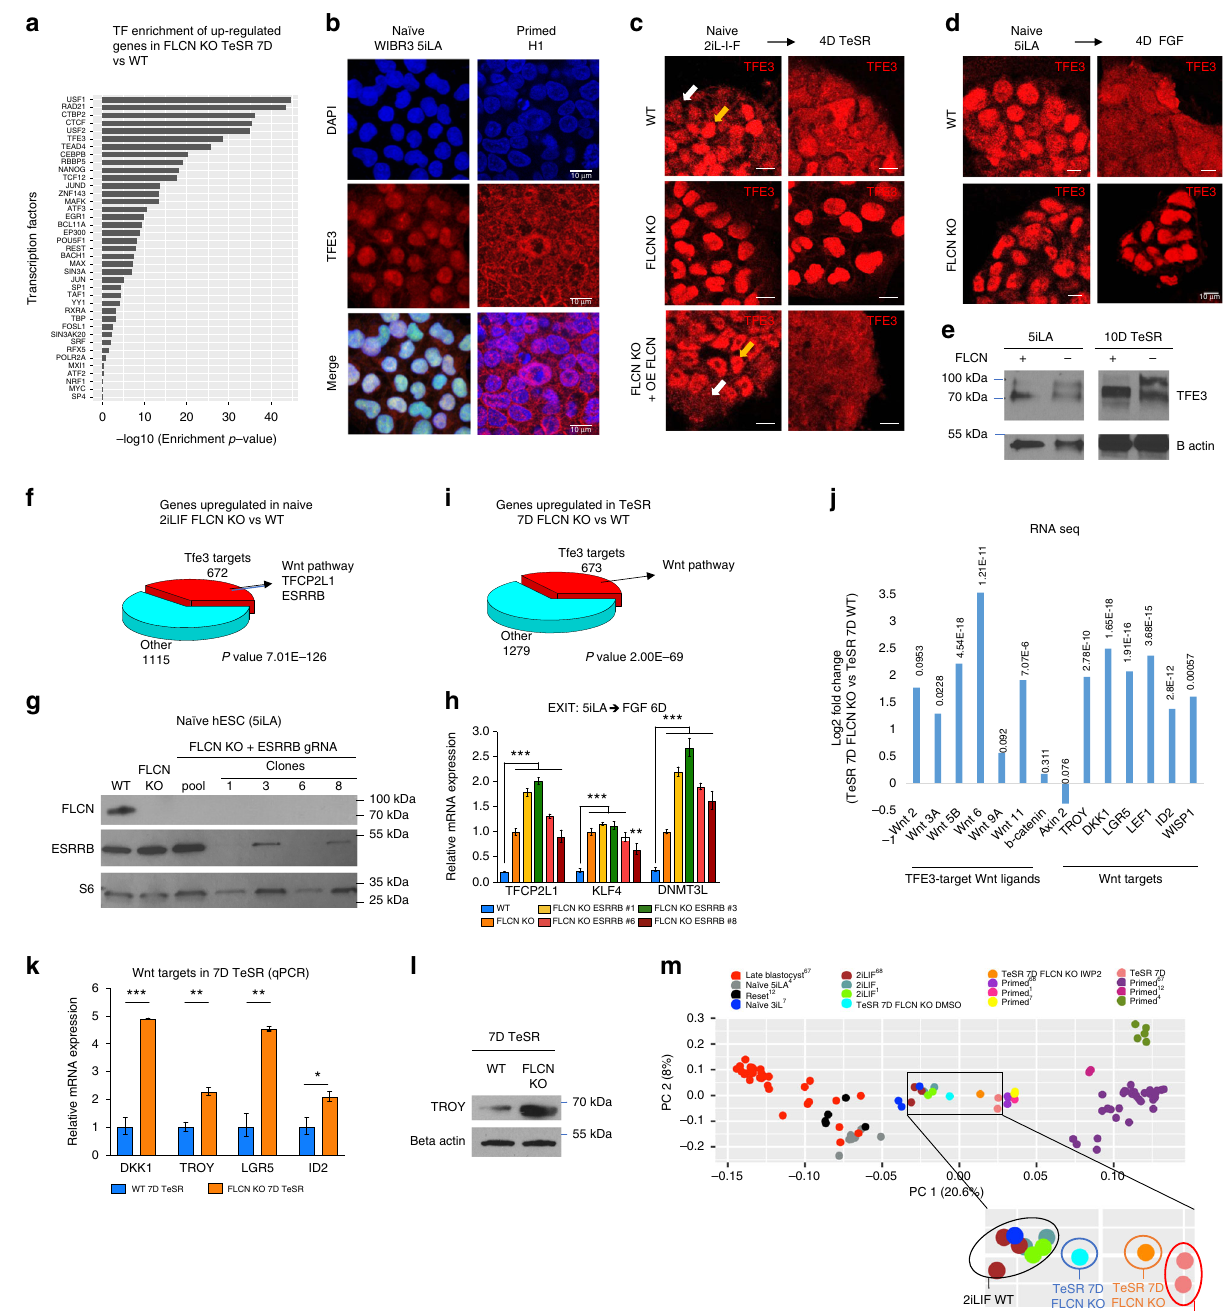
Fig. 4 FLCN regulates TFE3 subcellular localization in hESC. a Enrichment of transcription factor targets in genes that are up-regulated in FLCN KO 7D TeSR compared to WT 7D TeSR. b Immuno fl uorescence staining of TFE3 in naïve (WIBR3 5iLA) and primed (H1) hESC observed with confocal microscopy. c , d WT and FLCN KO lines were stained for TFE3 in naïve conditions (2iL-I-F, C; 5iLA, D) and 4 days after culture in TeSR ( c ) or FGF ( d ) media. TFE3 was detected in the nucleus in WT naive hESC and in FLCN KO grown in all conditions. Scale bars represent 10 μ m. e Western blot analysis of TFE3 in WT and FLCN KO in naïve (5iLA) and 10D TeSR samples. f TFE3 targets are upregulated in naïve hESC (2iL-I-F) FLCN KO compared to WT, including TFCP2L1, ESRRB, and Wnt pathway components. g Generation of FLCN/ESRRB double KO in naïve hESC. Western blot analysis of CRISPR-Cas9-generated ESRRB mutant clones in WIBR3 5iLA FLCN KO. h FLCN/ESRRB double mutant does not rescue FLCN KO phenotype during the exit of naïve pluripotency. RT-qPCR analysis of naive hESC markers (TFCP2L1, KLF4, and DNMT3L) in WIBR3 6D FGF (WT), WIBR3 FLCN KO 6D FGF, and WIBR3 FLCN KO/ESRRB mutants 6D FGF. S.e.m.; ** p <0.005, *** p <0.001; two-tailed t -test. i TFE3 targets are upregulated in 7D TeSR FLCN KO hESC compared to 7D TeSR WT hESC, including several Wnt pathway components. j TFE3-target Wnt ligands and Wnt pathway targets are up-regulated in naïve (2iL-I-F) hESC FLCN KO compared to WT (log2 fold change from RNAseq data is presented and p -value indicated). k , l Wnt-pathway targets are upregulated in 7D TeSR FLCN KO hESC compared to 7D TeSR WT hESC, as analyzed by RT-qPCR ( k , s.e.m.; * p <0.05,** p <0.005, *** p <0.001; two-tailed t -test, n = 3 biological replicates) and western blot ( l ). m Principal component analysis after RNA-seq analysis reveals that inhibition of Wnt by IWP2 during the exit of naïve state (Elf1 7D TeSR) rescues FLCN KO phenotype. RNA-seq from various pre-implantation in vivo human embryo 67 , naïve, and primed in vitro hESC were plotted, and separated in PC1 axis